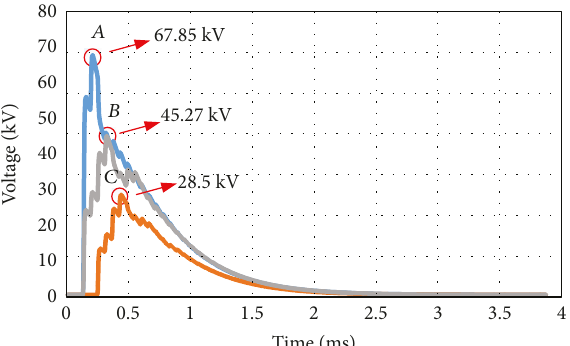
Figure 6: 16-mesh simulation model of regular grounding.